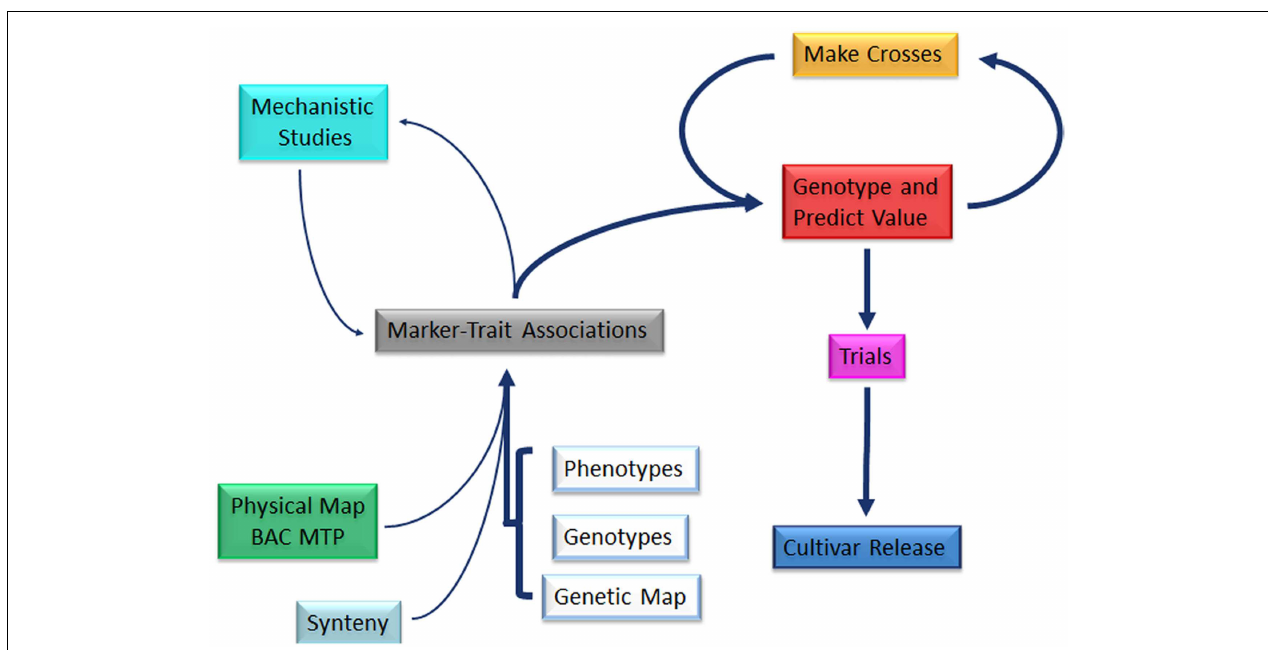
FIGURE 5 | General pathway of marker-assisted breeding strategies which rely heavily on the development of marker-trait associations.